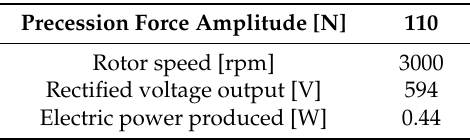
Table 14. Summary of the results concerning the entire